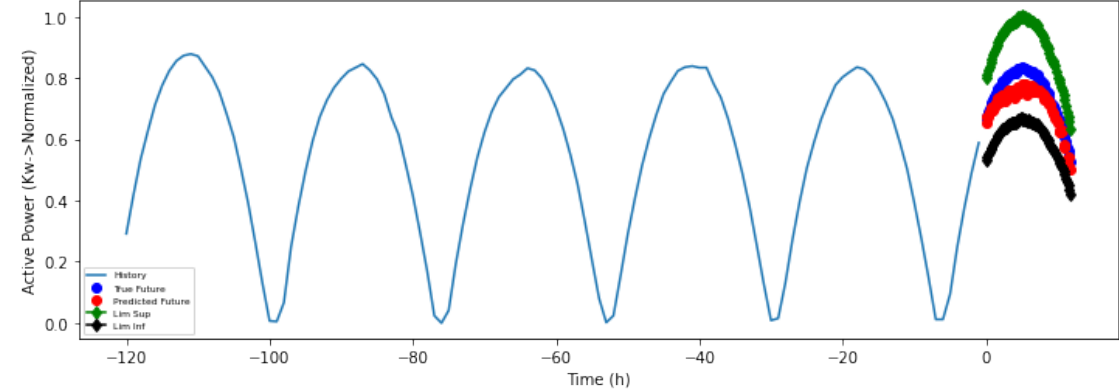
Figure 6. Magnified output power of the solar module in the evaluation window.